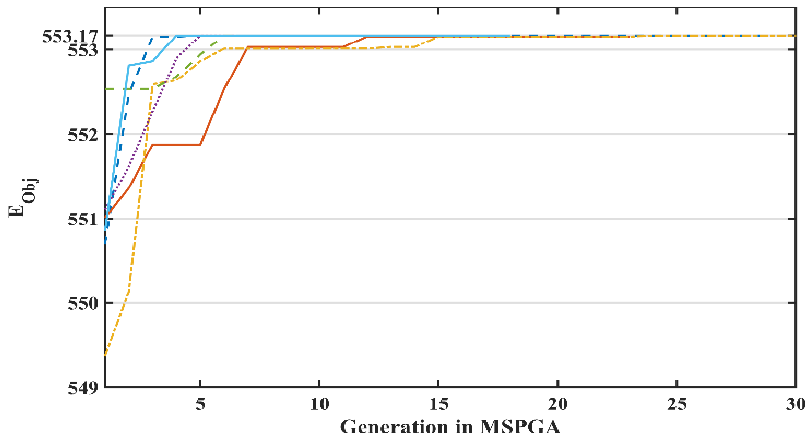
Figure 12. Trend of objective value with repeated MSPGA.